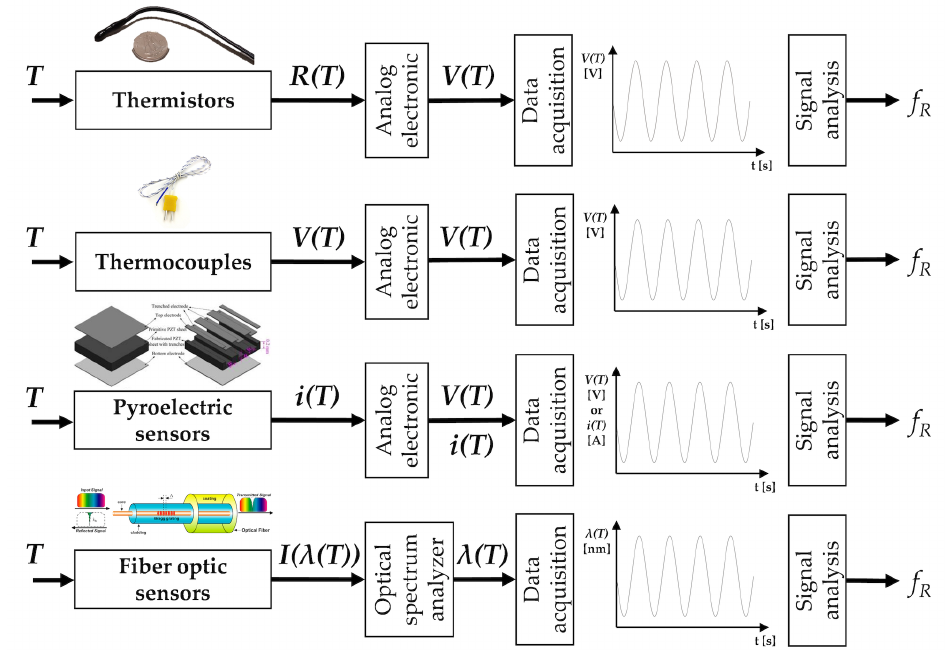
Figure 4. Temperature sensors: the main elements composing the measuring chain (sensor, analog electronics, data acquisition, post-processing or signal analysis stage) to estimate f R . Analog electronic stages vary between different sensors since the output quantities are different. R ( T ) , V ( T ) , i ( T ) , I ( λ ( T ) ) are resistance, voltage, current and light intensity changes caused by the temperature ( T ), respectively. V ( T ) is the voltage output. The pyroelectric sensor figure is adapted from [88]; the fiber-optic